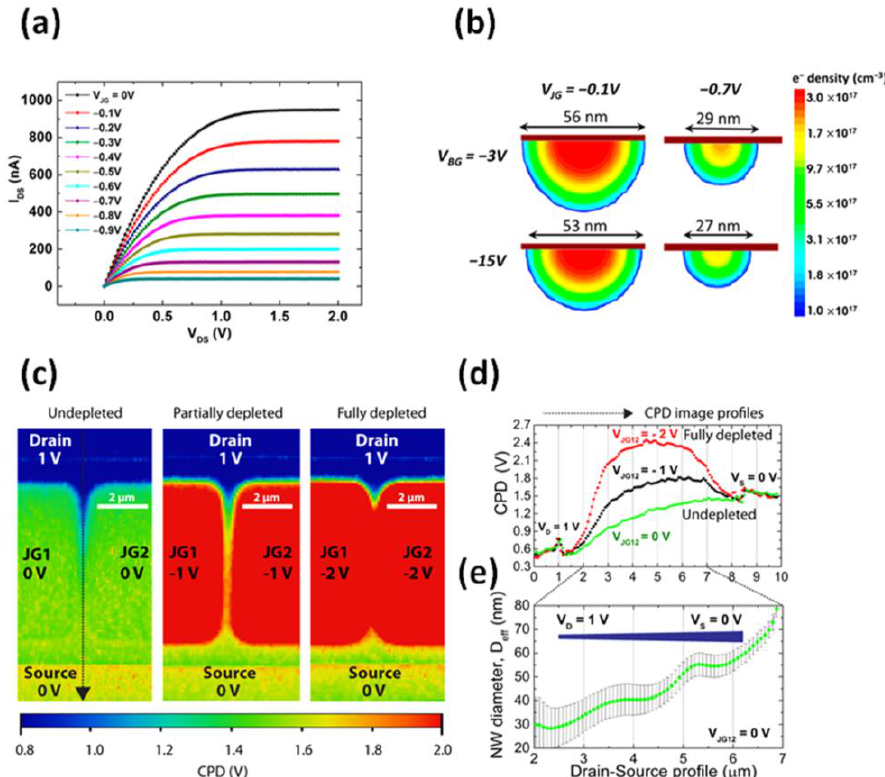
Figure 3. Electrical characterization of an EFN gas sensor. ( a ) An I DS vs V DS curve for various V JG values. Note that I DS decreases as V JG becomes more negative; ( b ) numerical simulations of the electron density in the conducting channel of an EFN gas sensor; ( c ) contact potential difference (CPD) images of the EFN active area; and ( d ) CPD profiles along the EFN channel from source to